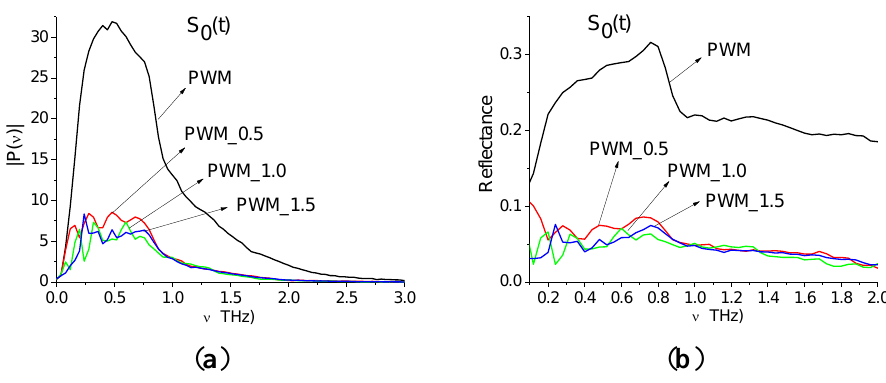
Figure 22. Fourier spectra ( a ) and reflectance ( b ) of the main pulses S 0 ( t ) of the PWM_0.5, PWM_1.0, PWM_1.5 and PWM signals